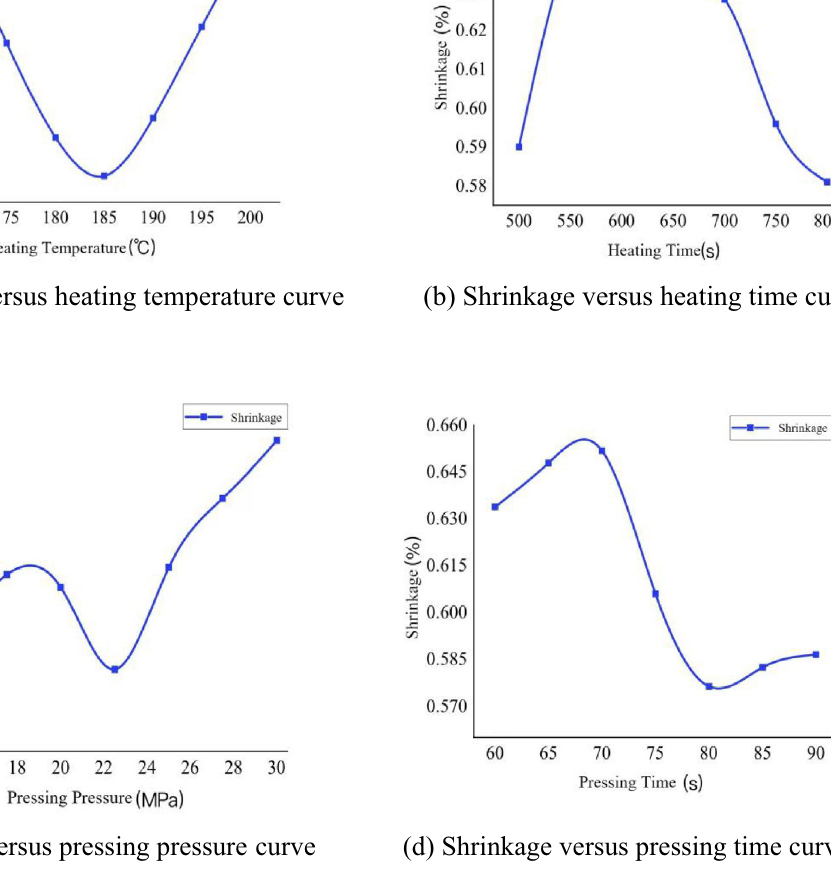
Figure 23. Variation curve of shrinkage rate with process